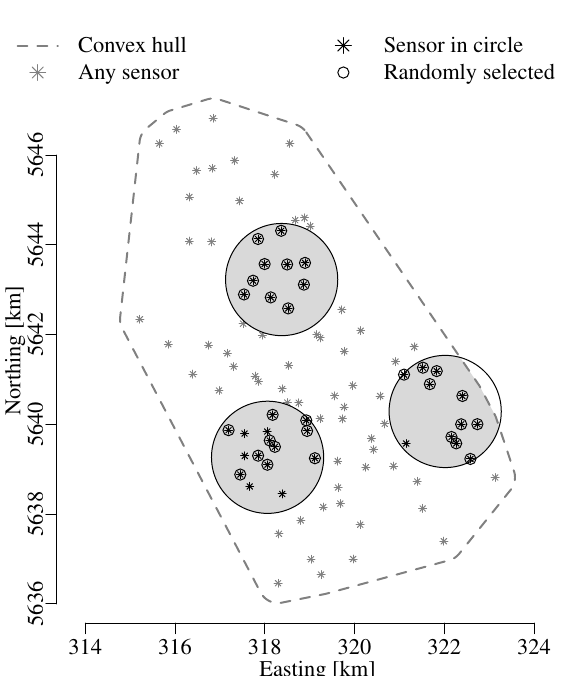
Figure 7. Three representative realizations of randomly selected cir- cles falling within the study domain, using circle radii of 1.25km, and a fixed sensor density of 2km − 2 . The coordinates (UTM pro- jection, grid zone 32U) of all pyranometers of the Jülich campaign are shown, along with their corresponding convex hull, using a cir- cumferential padding amounting to the mean minimum distance be- tween sensors (about 440m). Valid circles used to compute area- averaged quantities must overlap the domain by at least 75% and include a specified number of pyranometers. If there is an excess of pyranometers within a randomly chosen circle, random subset selection will ensure the adherence to a constant sensor